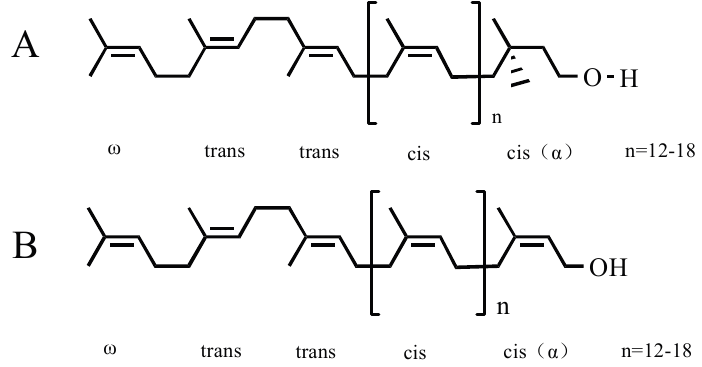
Figure 1. Chemical structure of dolichol and polyprenol of Ginkgo biloba L. ( A ) Dolichol; ( B ) polyprenols of Ginkgo biloba L.